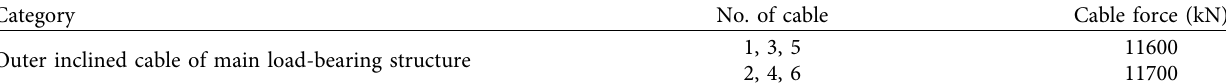
Table 5: Main load-bearing structure outer inclined cable forces.